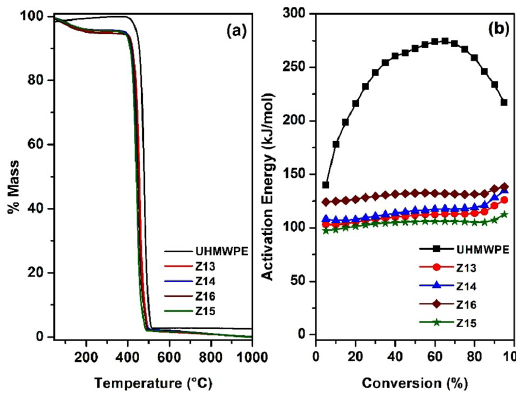
Figure 8. (a) Mass loss curves under the heating rate of 10 °C·min -1 and (b) activation energy as a function of the conversion in the UHMWPE degradation